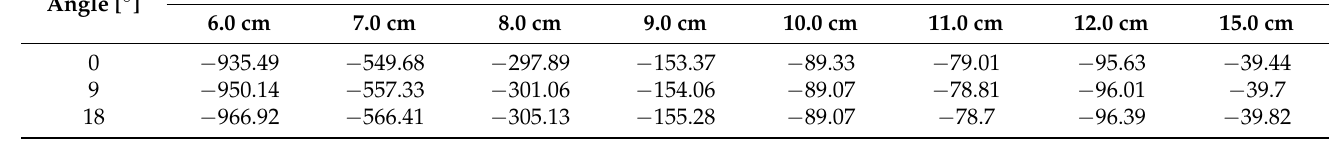
Table 4. Estimated values of the B y component of magnetic induction as a function of rotation angle and measurement